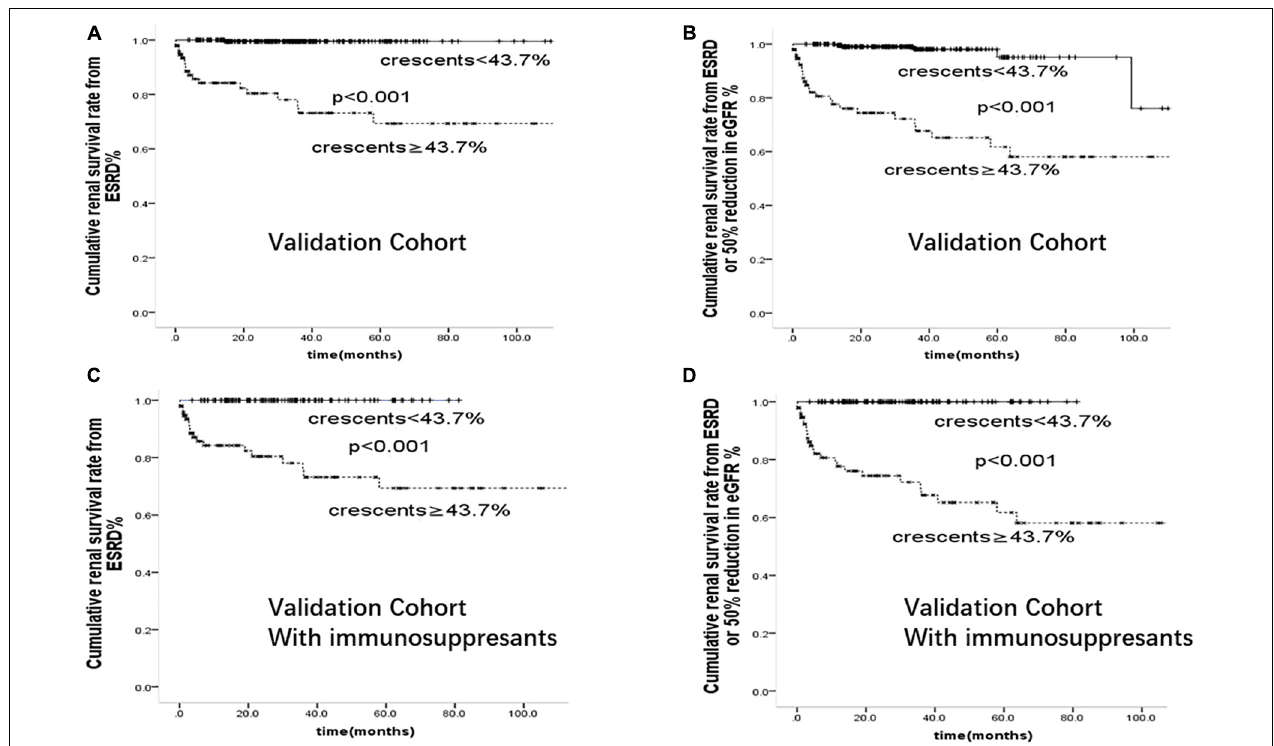
FIGURE 5 | Cumulative renal survival rate from (A) : ESRD (B) : ESRD or 50% reduction in eGFR in 346 cases of IgAN patients from validation Cohort. Cumulative renal survival rate from (C) : ESRD (D) : ESRD or 50% reduction in eGFR in 206 cases of IgAN patients treated with immunosuppressants from validation